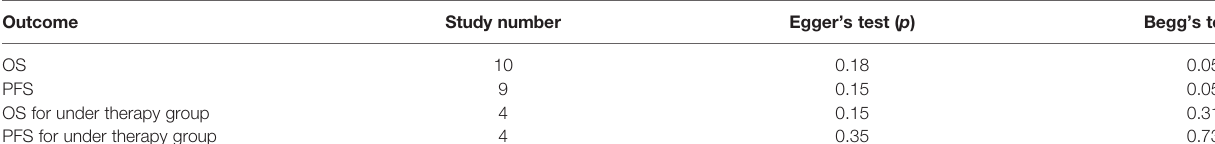
TABLE 3 | Results of Egger ’ s and Begg ’ s tests for publication bias.